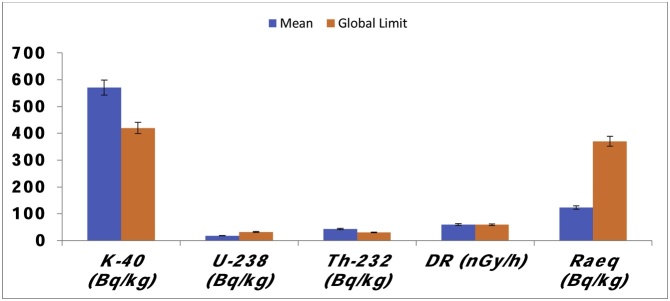
Mean activity concentrations of 40K, 232Th & 238U, Dose rate (DR) and the Radium equivalent.